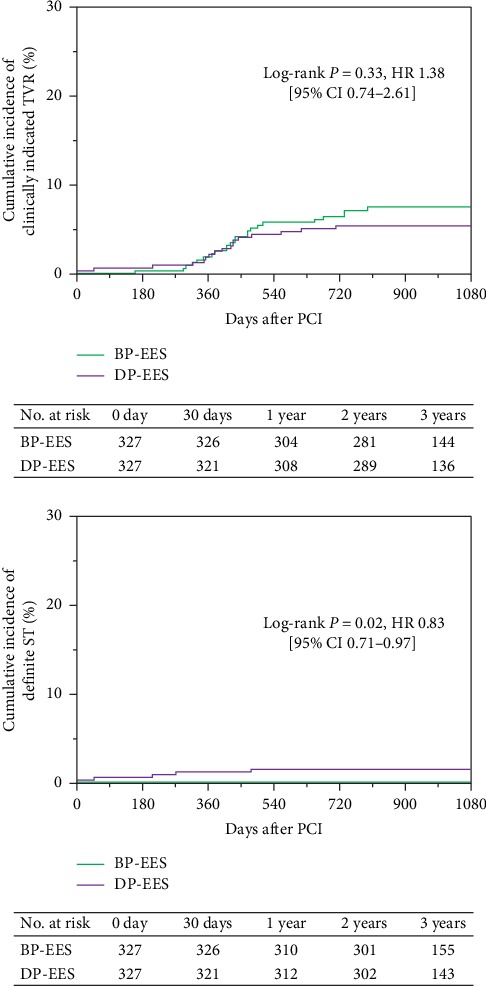
Cumulative incidence of the secondary endpoints.